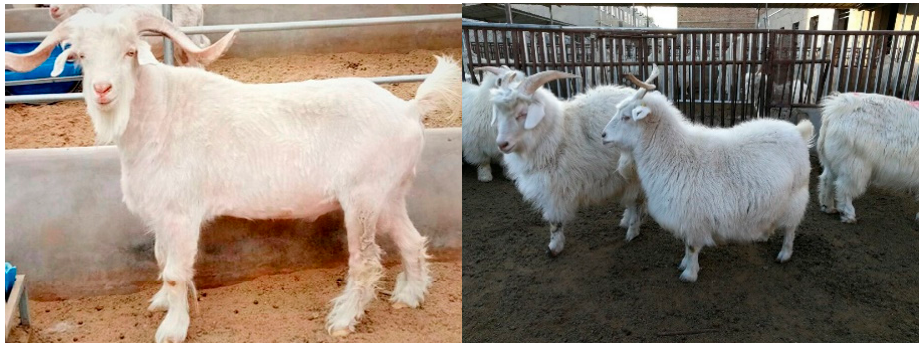
Figure 1. Shaanbei white cashmere goats.